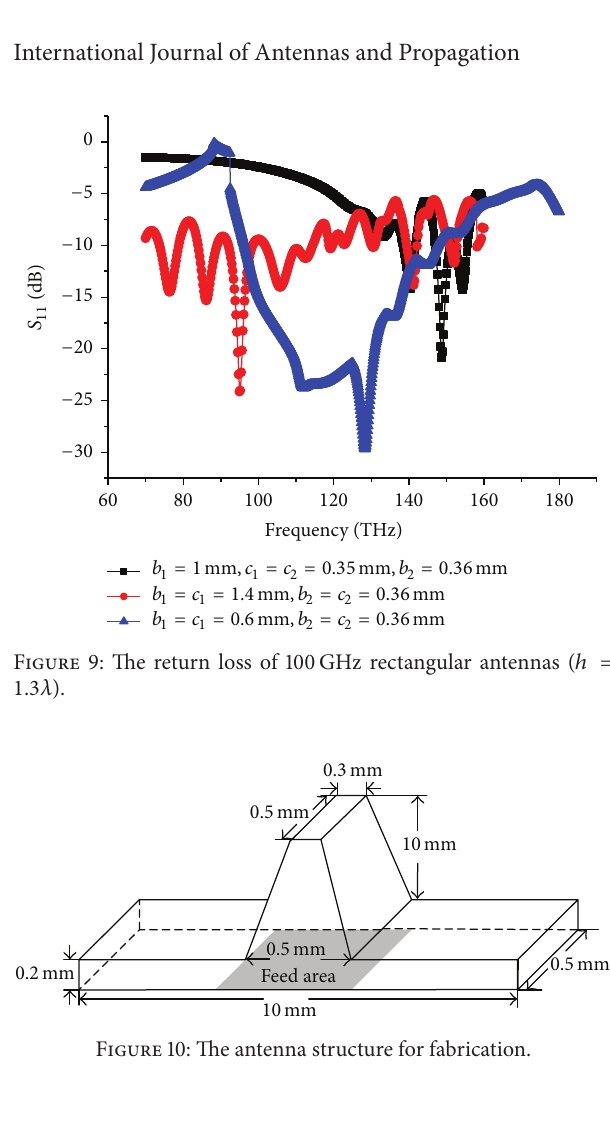
From (8), the bottom width is 0.3158 mm < 𝑐 1 < 0.4464 mm. From (9), we obtain 0.1119 mm < 𝑐 2 < 0.3158 mm. The length of antenna is ℎ = 10 mm (4 𝜆 ). Because the modal equations are approximate, the antenna dimensions derived from (8), (9), and (10) are tuned slightly. The opti- mized dimensions are 𝑏 1 = 𝑏 2 = 𝑐 1 = 0.5 mm and 𝑐 2 = 0.3 mm as shown in Figure 10.